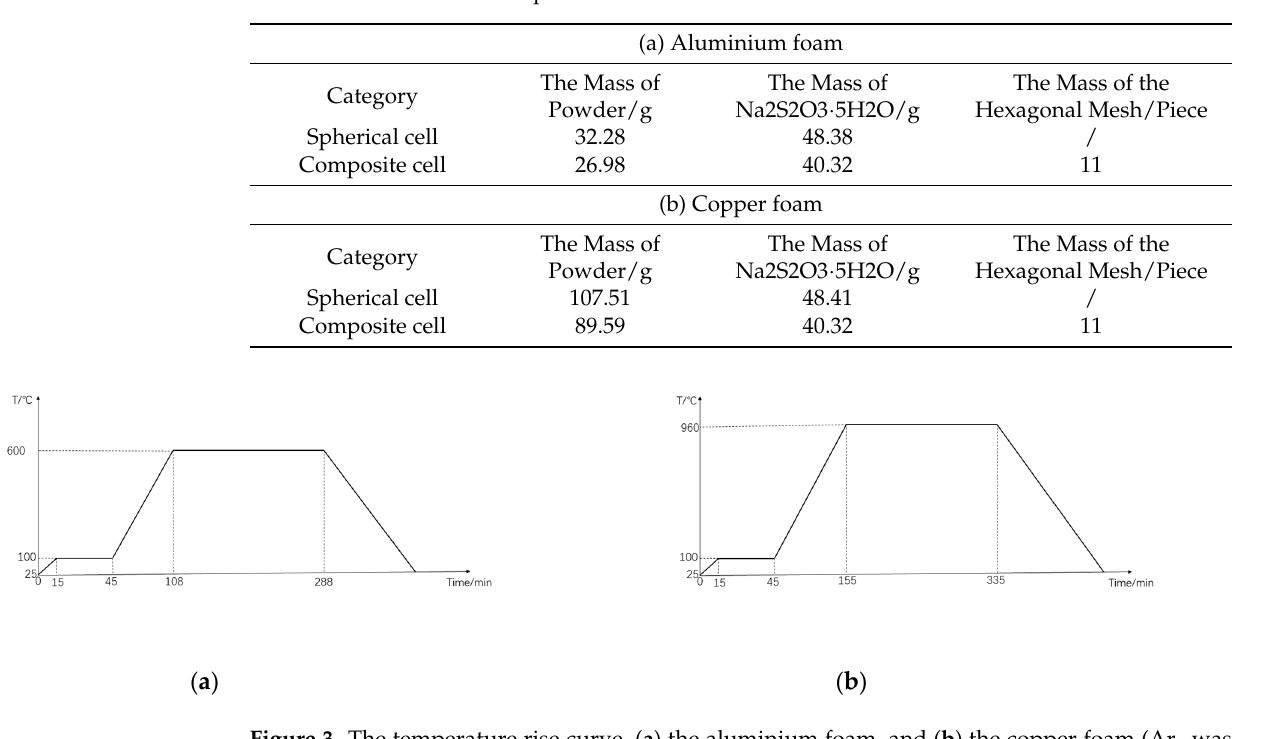
Table 1. The ratio of the components.